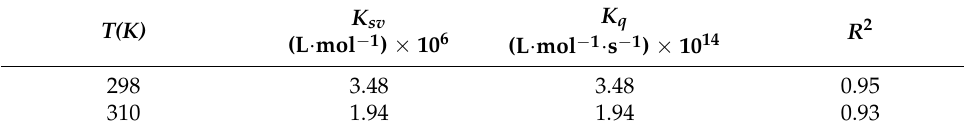
Table 1. Ksv and Kq values of TDD and Cav1 protein at 298 K and 310 K.